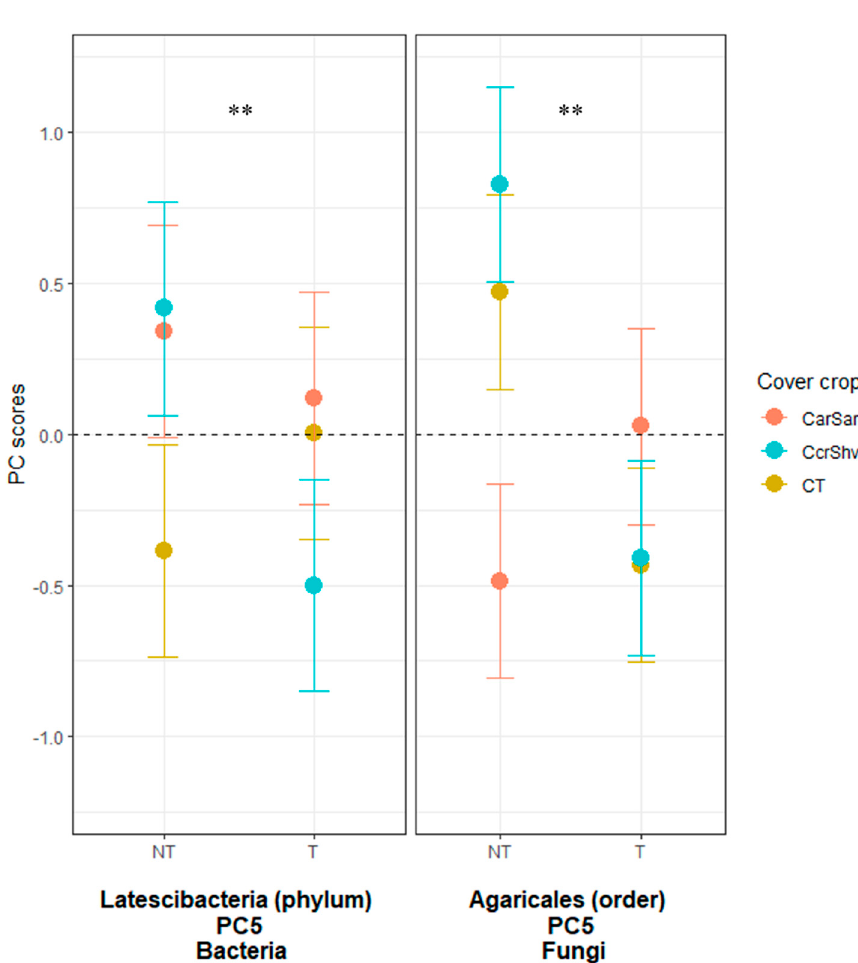
Figure 3. Response pattern of the bacterial and fungal indicator OTUs to cover cropping and tillage. Visual representation of the combined results of the principal component analyses (PCAs) and their mean separation procedure showing the most responsive bacterial and fungal indicator OTUs based on their effects on relative abundances following five years of cover cropping and tillage within corn–soybean rotations. For each taxon, the response of each OTU to cover crop rotation and tillage treatments was calculated as the mean PC score multiplied by the PC loading score of a listed OTU. Likewise, the whiskers represent the standard error of the mean PC scores for each cover crop and tillage treatment multiplied by the absolute value of each OTU loading. Cover crop rotations: CarSar—annual ryegrass CC following both corn and soybean (red), CcrShv—cereal rye following corn and hairy vetch following soybean (blue), CT—bare fallow control (yellow). The responses to cover cropping treatments are grouped by tillage practices on the x -axes; NT—no-till, T—chisel tillage. **, significant at the 0.05 probability level.